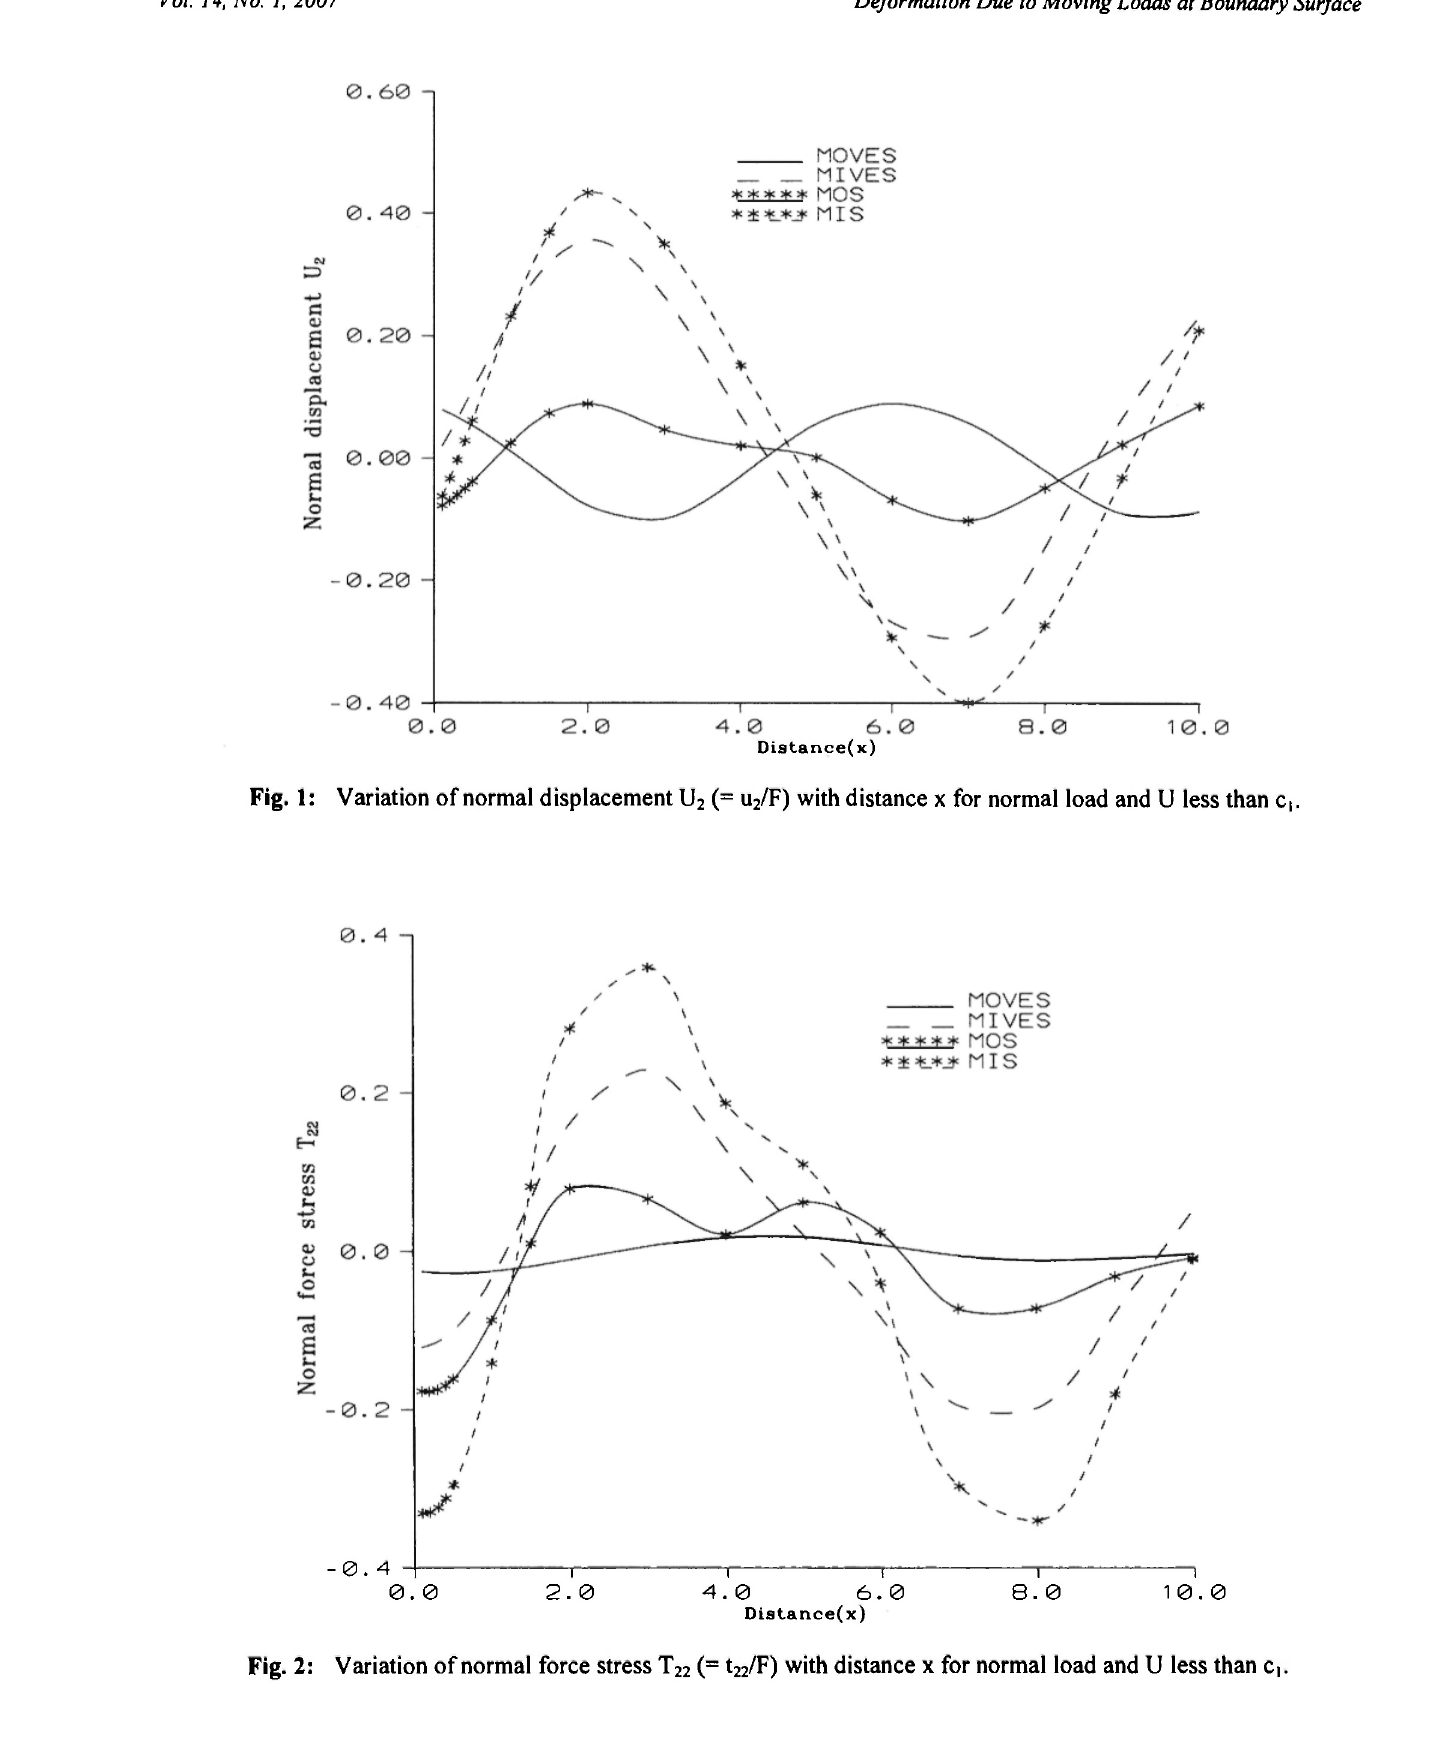
Fig. 2: Variation of normal force stress T 2 2 (= t 2 2/F) with distance χ for normal load and U less than